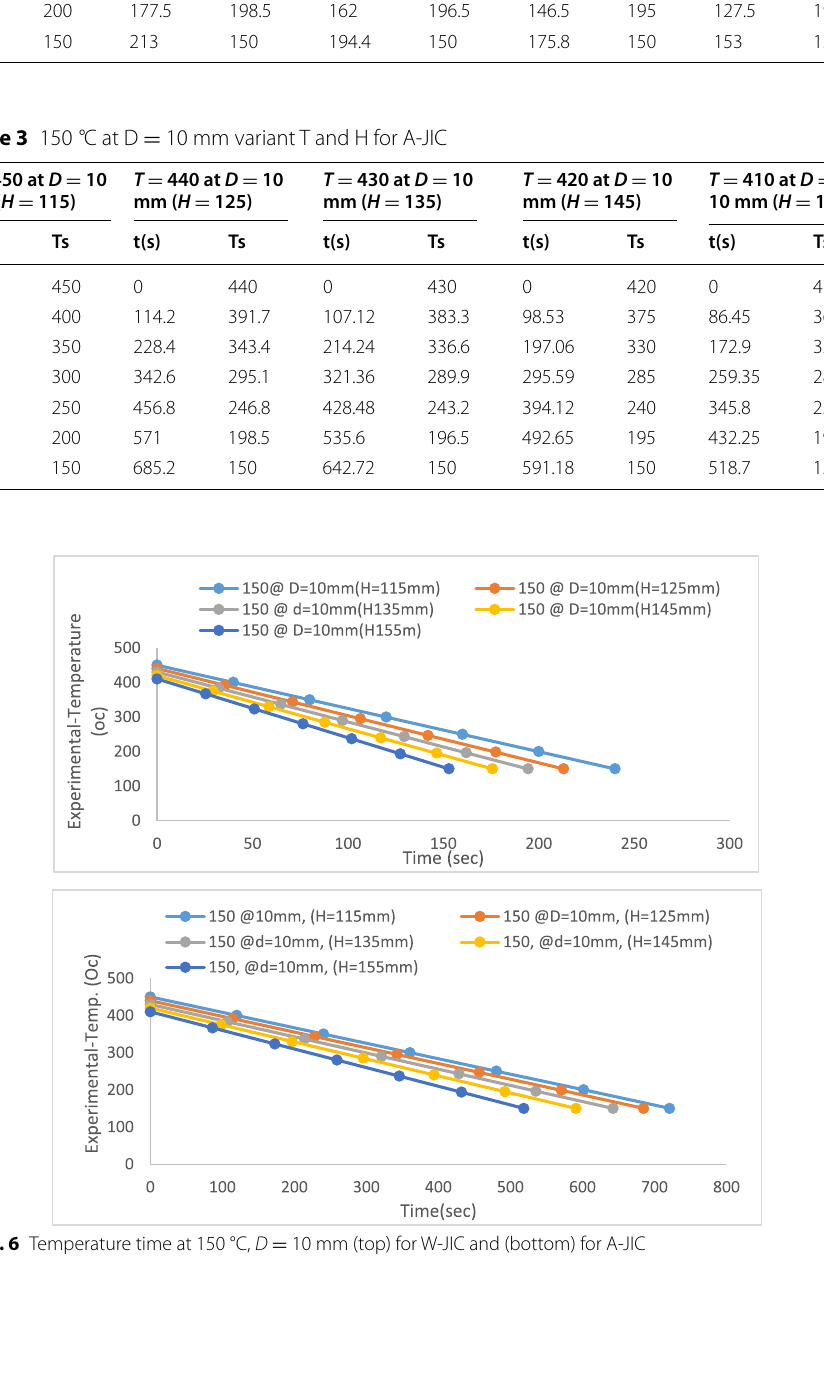
10 mm (top) for W-JIC and (bottom) for =